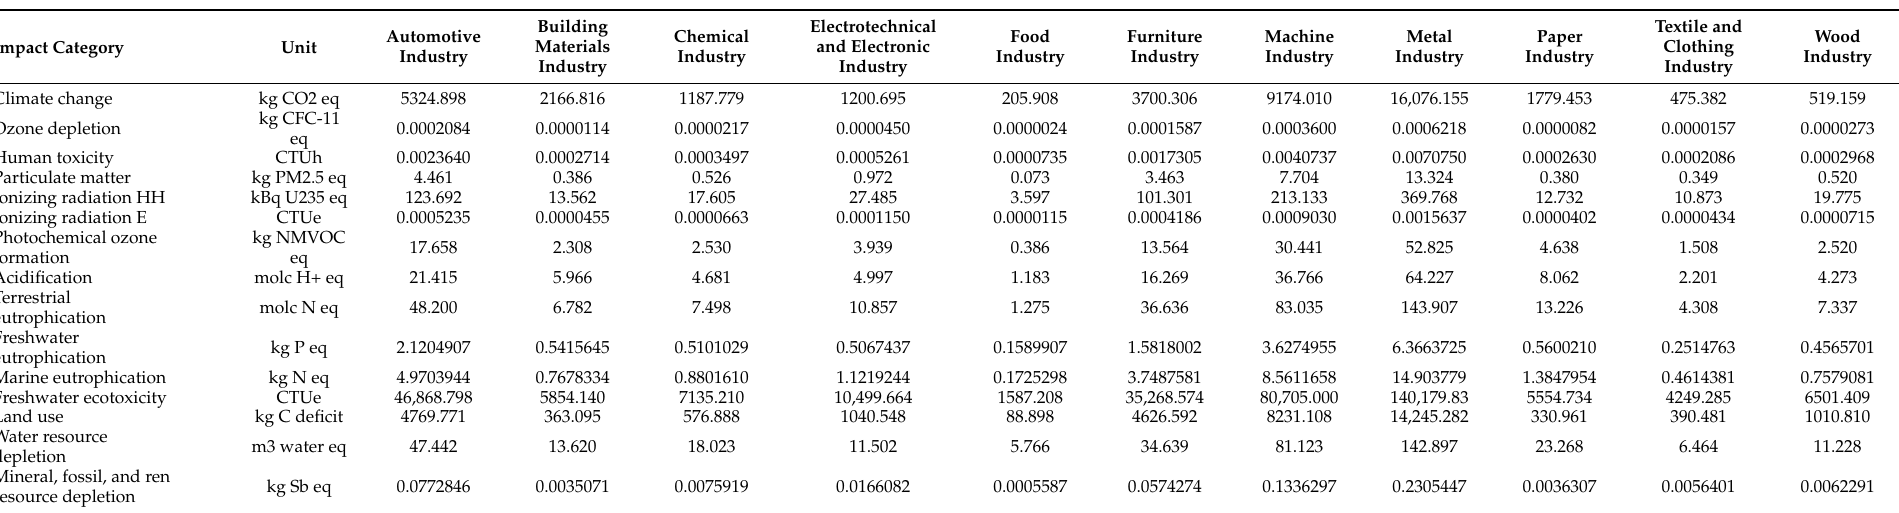
Table A2. Environmental profiles of manufacturing in